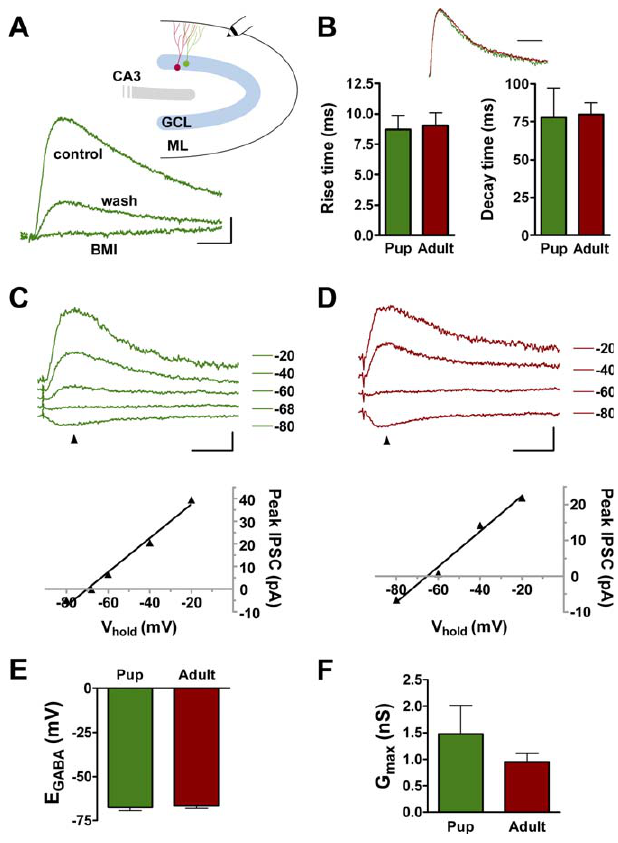
Figure 5. GABAergic Inputs Evoked by ML Stimulation (A) Example of evoked IPSCs recorded from a pup-born DGC in response to extracellular stimulation of the ML before (control), during (BMI), and after (wash) application of 20 l M BMI. Scale bars indicate 25 ms, 20 pA. Inset: schematic diagram of the DG showing the position of the bipolar electrode for the stimulation of ML interneurons. Experiments were carried out with internal solution containing low [Cl (cid:2) ]. (B) Kinetics of IPSCs evoked on pup versus adult DGCs (pup, n ¼ 6; adult, n ¼ 14; rise time, p ¼ 0.85; decay time, p ¼ 0.90, paired t -tests). Inset: scaled averages of IPSCs (pup, green; adult, red). Scale bar indicates 50 ms. (C) and (D) Examples of I-V curves of evoked IPSCs recorded from pup (C) or adult (D) DGCs. Top: sample traces of IPSCs recorded at the holding potentials shown on the right (mV). Scale bar indicates 50 ms, 10 pA. Bottom: I-V plots measured at the time indicated by the arrowheads. (E) E GABA of IPSCs (pup, n ¼ 7; adult, n ¼ 11; p ¼ 0.67, t -test). (F) Slope conductance measured at the IPSC peak ( n, same as in [E]; p ¼ 0.23; t -test). All experiments conducted in the presence of kyn (4 mM) in neurons aged 12 wk (P7) and 7 wk (P42). DOI: